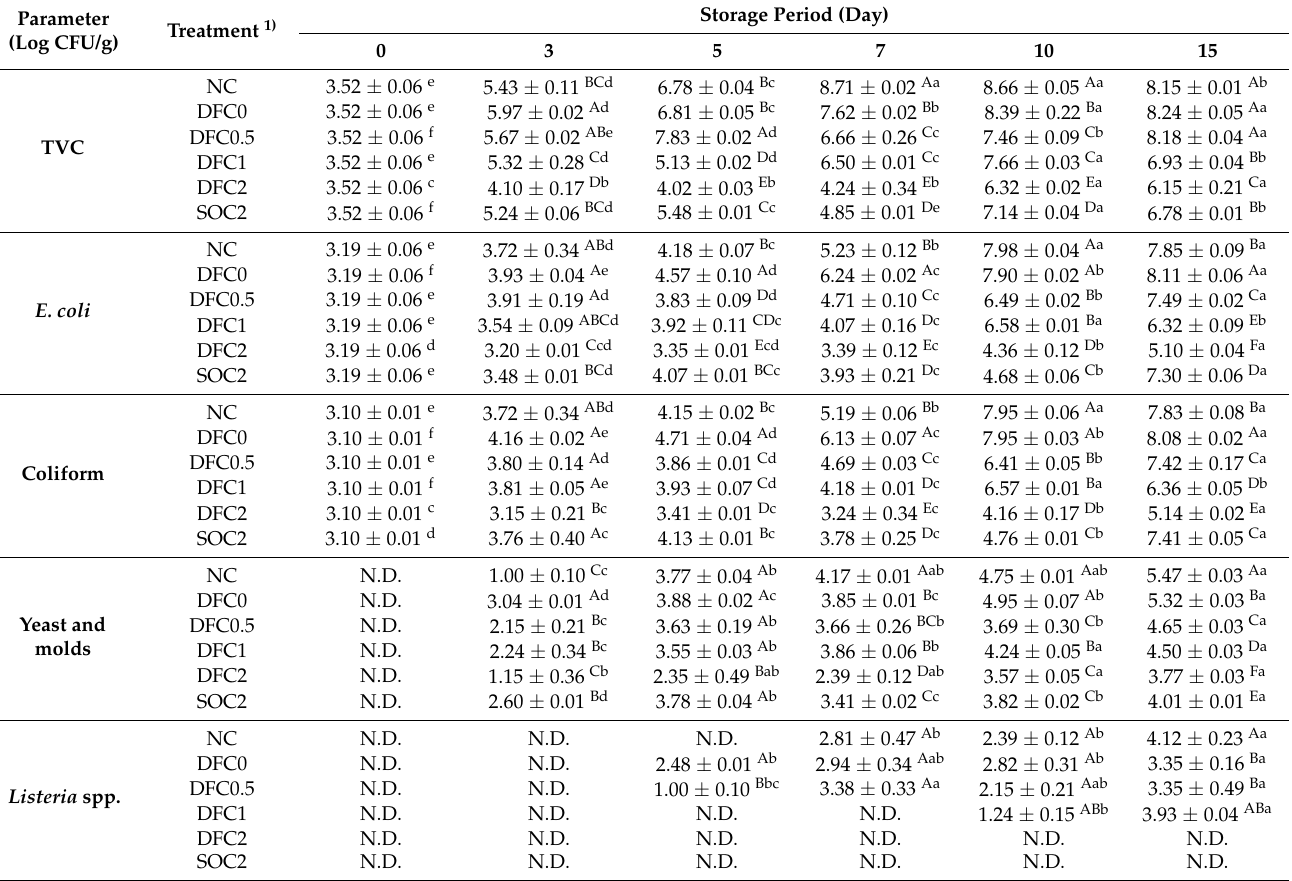
Table 2. Microorganisms in coated chicken meat during storage at 4 ± 1 ◦ C for up to 15